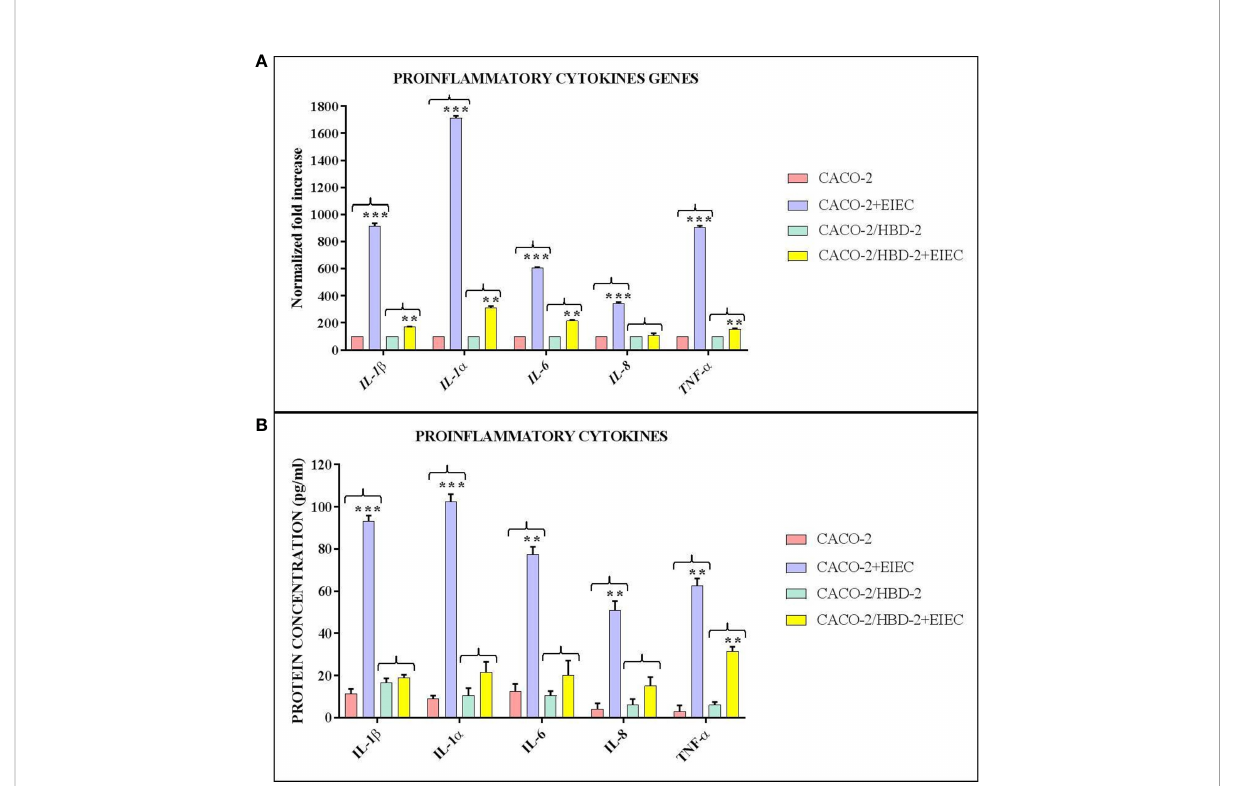
FIGURE 2 Comparison between relative gene expression (A) and protein concentration (B) in transfected and untransfected Caco-2 cells infected with EIEC. Data are representative of three different experiments ± SD and are expressed as (A) percentage of expression of the relative mRNAs in each group compared to uninfected cells (ctrl), arbitrarily assigned as 100%, or (B) as effective protein concentration. Signi fi cant differences are indicated by *p<0.05, **p<0.01,